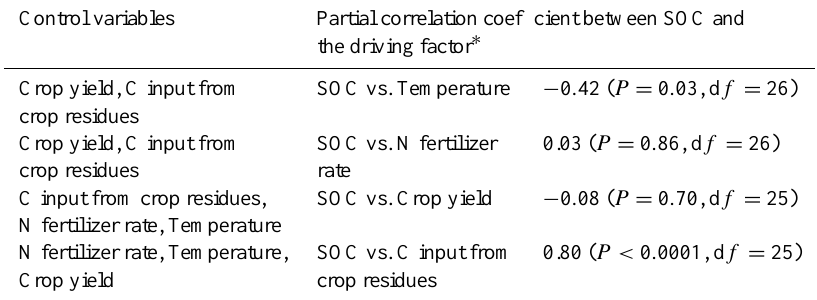
Table 2. Partial correlation analysis between SOC content of cropland and driving factors in Huantai County. Control variables Partial correlation coefficient between SOC and the driving factor ∗ Crop yield, C input